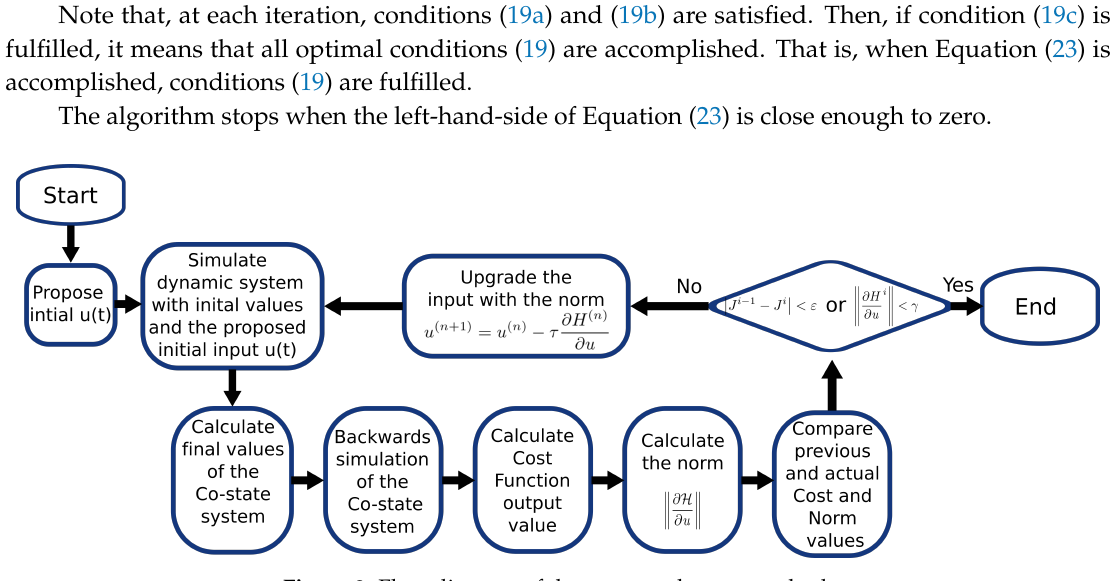
Figure 2. Flow diagram of the steepest descent